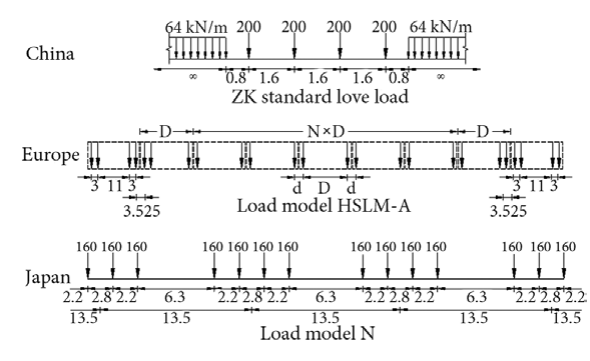
Fig. 3. Manhole in the two adjoining beams at a beam end, in mm